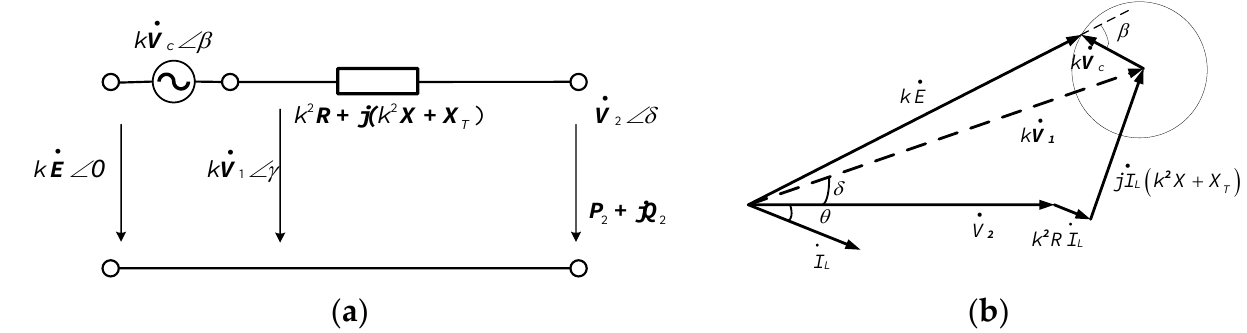
Figure 8. Equivalent circuit and phasor diagram of power system with Flexible OLVR transformer. ( a ) The equivalent circuit of power system with Flexible OLVR transformer; ( b ) The phasor diagram of power system with Flexible OLVR transformer.